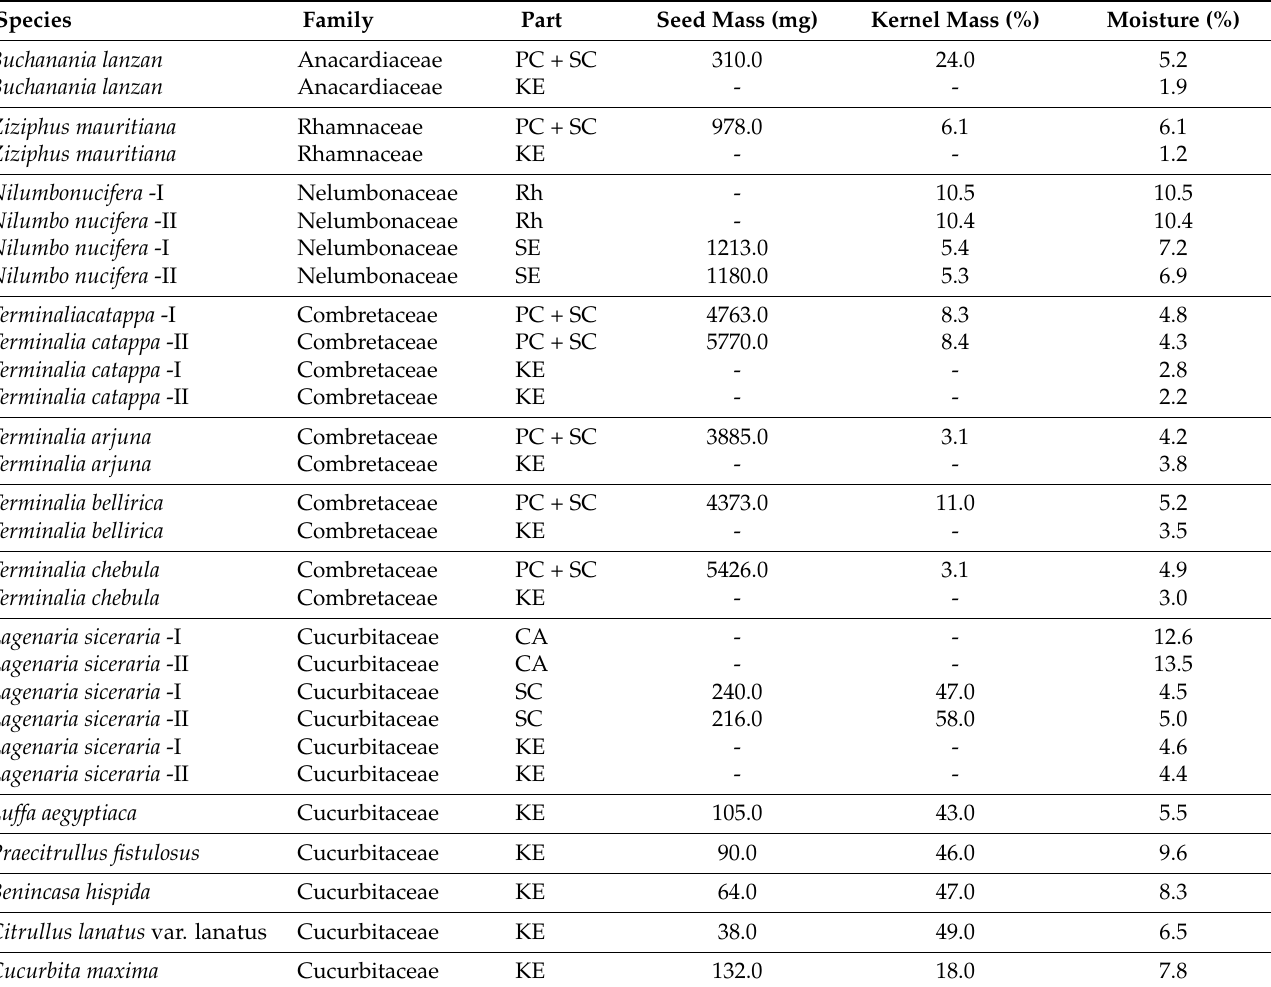
Table 1. Physico-chemical characteristics of herbal